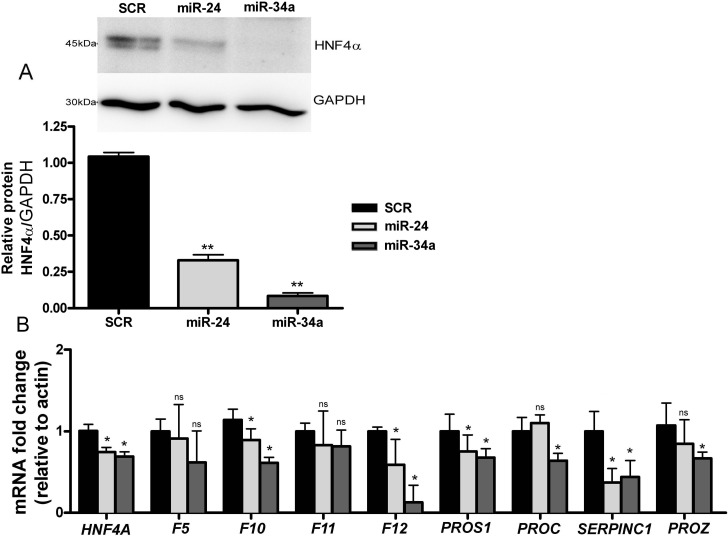
Effect of miRNAs on HNF4A and coagulation factors expression in HepG2.HepG2 cells were transfected with 100 nM mimic precursors of miR-24, miR-34a or SCR. Protein lysates and total RNA were obtained after 48 h incubation and analyzed. A) Densitometric analysis of HNF4α protein expression transfected with SCR, miR-24, and miR-34a; representative western blot. B)qRT-PCR analysis of HNF4A and coagulation factors mRNA expression. The asterisk indicates a statistically significant difference (P < 0.05) and “ns” indicates a statistically non-significant difference (P > 0.05). Results are mean ± SD of three independent experiments performed in triplicate.